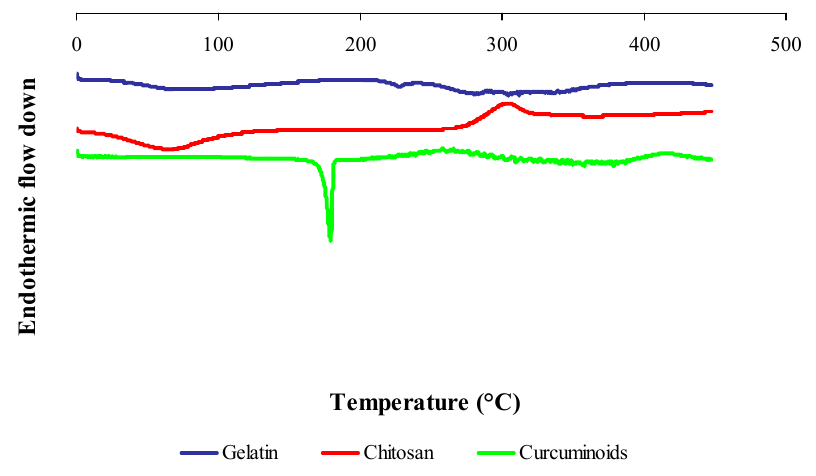
Figure 4. Differential scanning calorimetry (DSC) thermograms of raw material powders: gelatin, chitosan and curcuminoids.